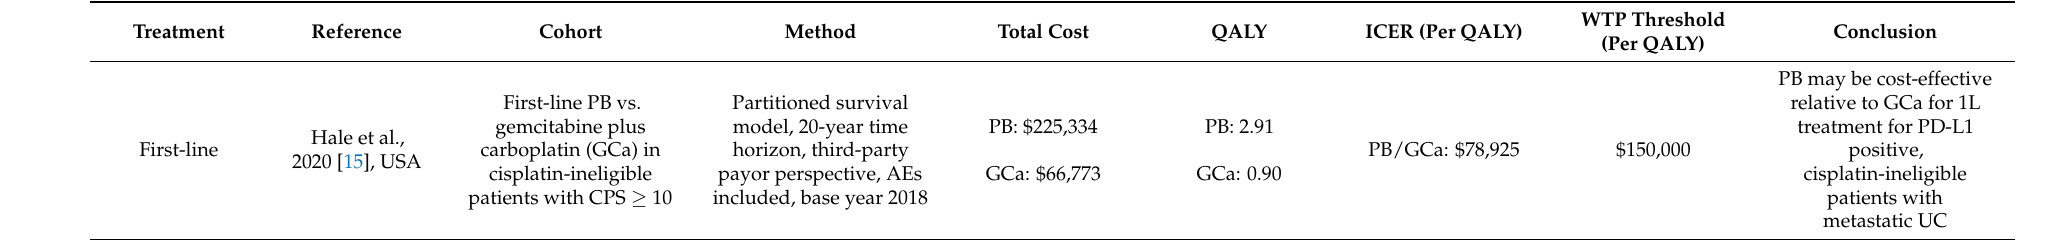
Table 2. CEAs in advanced